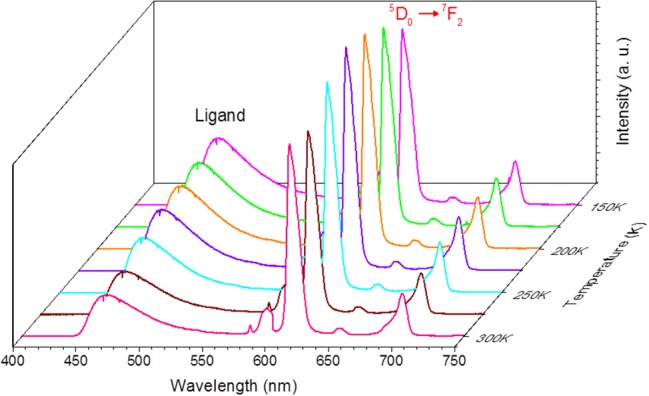
Emission spectra of compound EuW10@UiO-67 in the range 150–300 K with the excitation fixed at 336 nm.